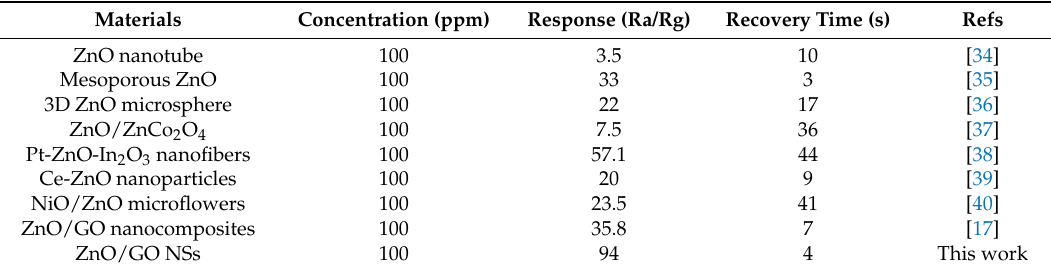
Table 1. The sensing properties comparison of graphene-like porous ZnO/graphene oxide nanosheets with the reported acetone vapor